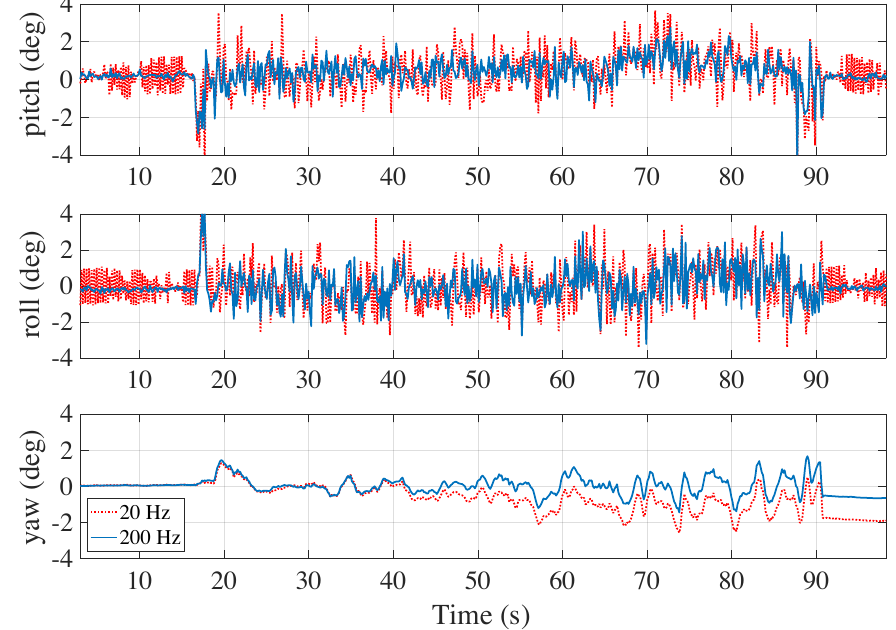
Figure 7. The attitude pitch, roll and yaw angles are here plotted during a flight which includes both a take-off and a hovering phase. The blue solid lines denote the output signals from the Madgwick fusion filter elaborated on board at the frequency rate of 200 Hz, whereas the red dotted lines are computed at 20